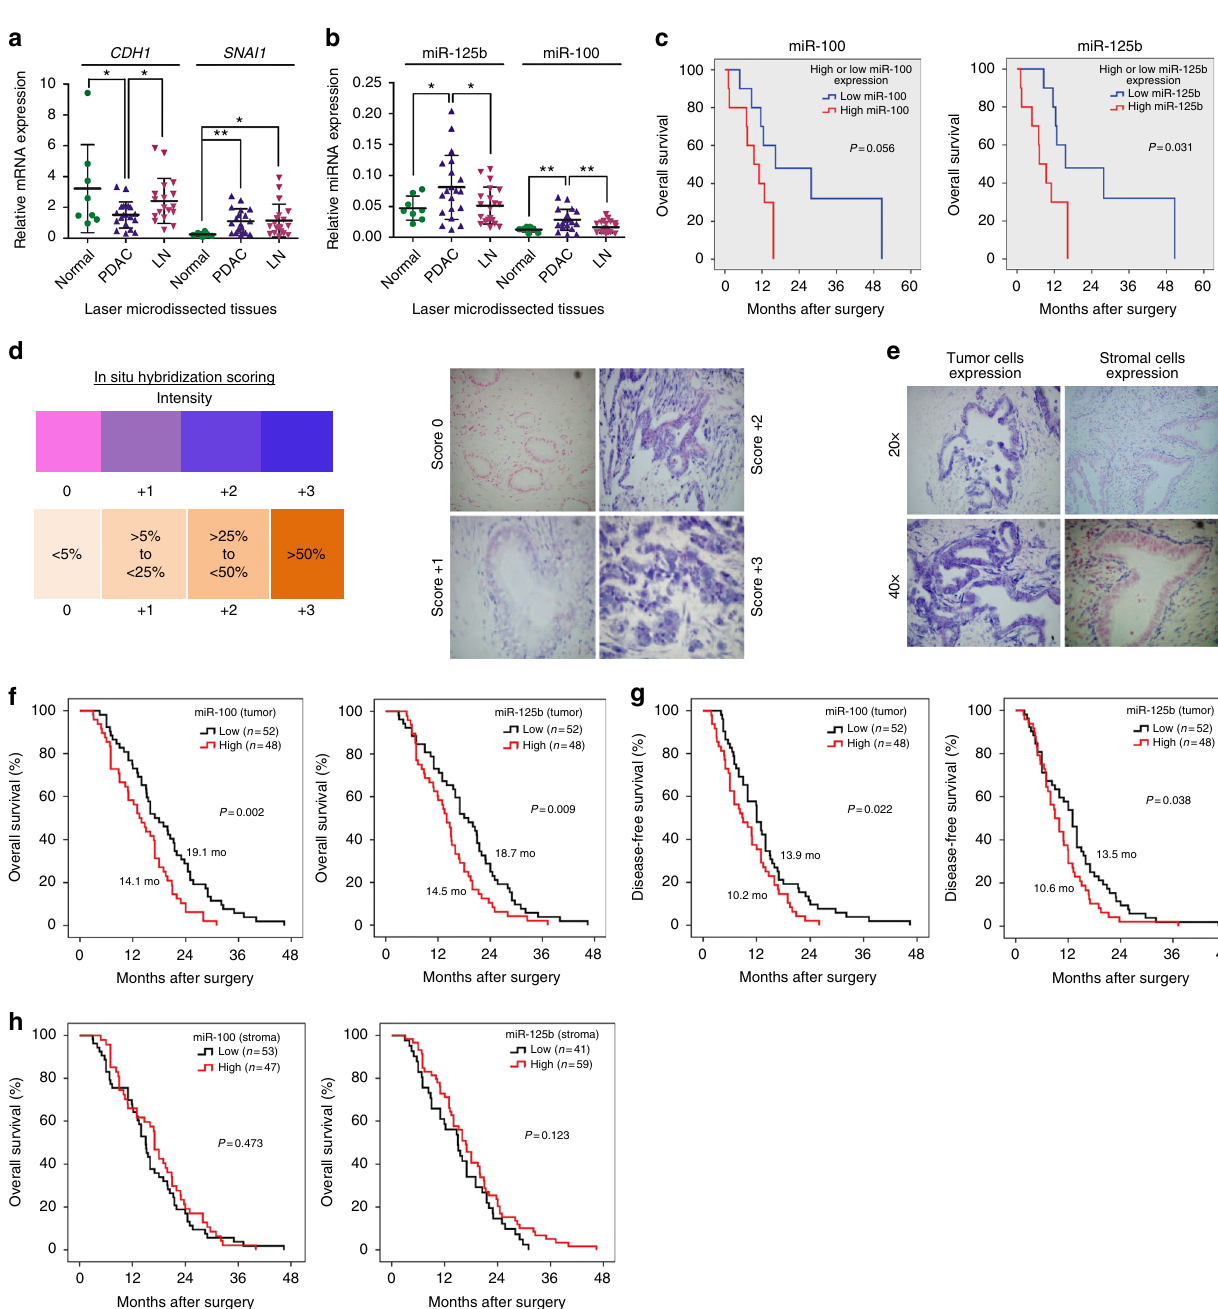
Fig. 5 miR-100 and miR-125b are up-regulated in PDAC tumors from patients. a RT-qPCR for CDH1 or SNAI1 in laser microdissected tissue samples (adjacent normal n = 8, PDAC n = 20, in fi ltrated lymph-node (LN) n = 20). Results were normalized to GAPDH levels. b RT-qPCR for miR-100 or miR-125b in samples described in a . Results were normalized to RNU44 levels. In a , b results are shown as mean of three technical replicates± s.e.m.* P -value < 0.05, ** P -value < 0.01, *** P -value < 0.001. P -values were calculated using two-tailed Student ’ s t test. c High levels of miR-100 (left; 9.7 months (95% CI 6.2 –